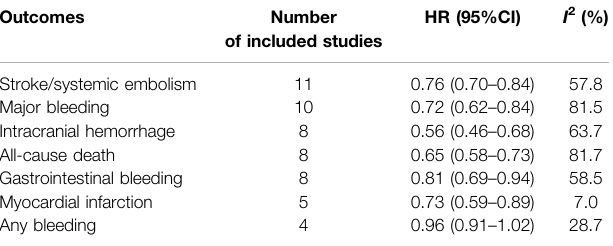
TABLE 2 | Comparison of reduced-dose of Rivaroxaban vs.